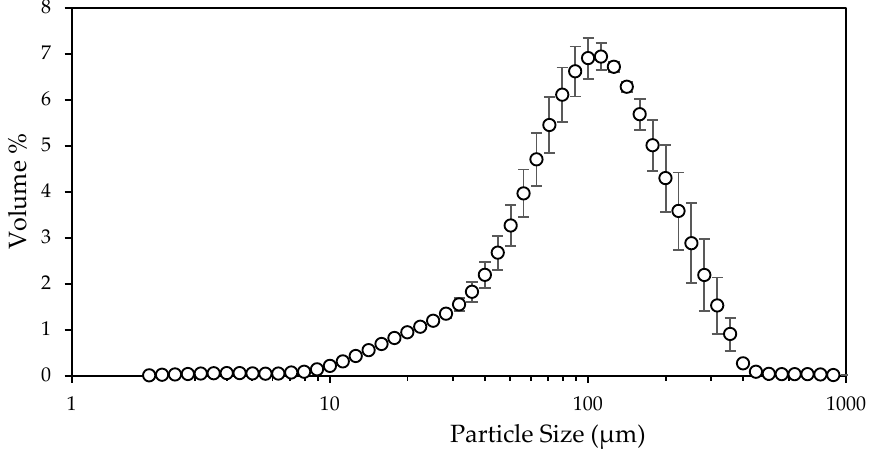
Figure 1. PSD of Nd 2 (SO 4 ) 3 .8H 2 O seeds.